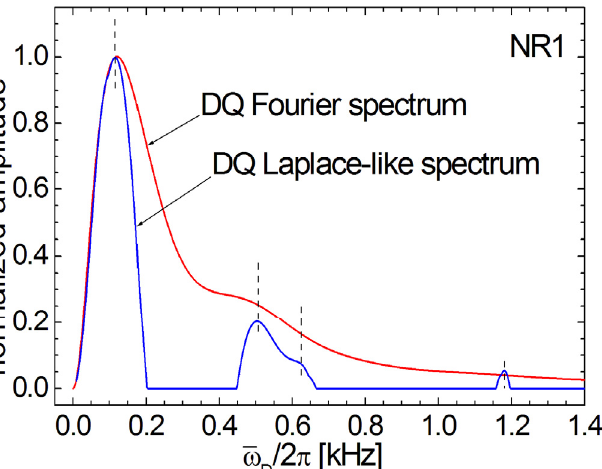
Figure 12. The comparison of 1 H DQ Fourier and DQ Laplace-like spectra for the NR1 natural rubber sample, natural ages during six years are shown. The two spectra were renormalized in order to have the maximum value equal to one. The vertical dashed lines were drawn to cross the Fourier and Laplace-like spectra for the position of the local maxima for the four peaks corresponding to Laplace-like